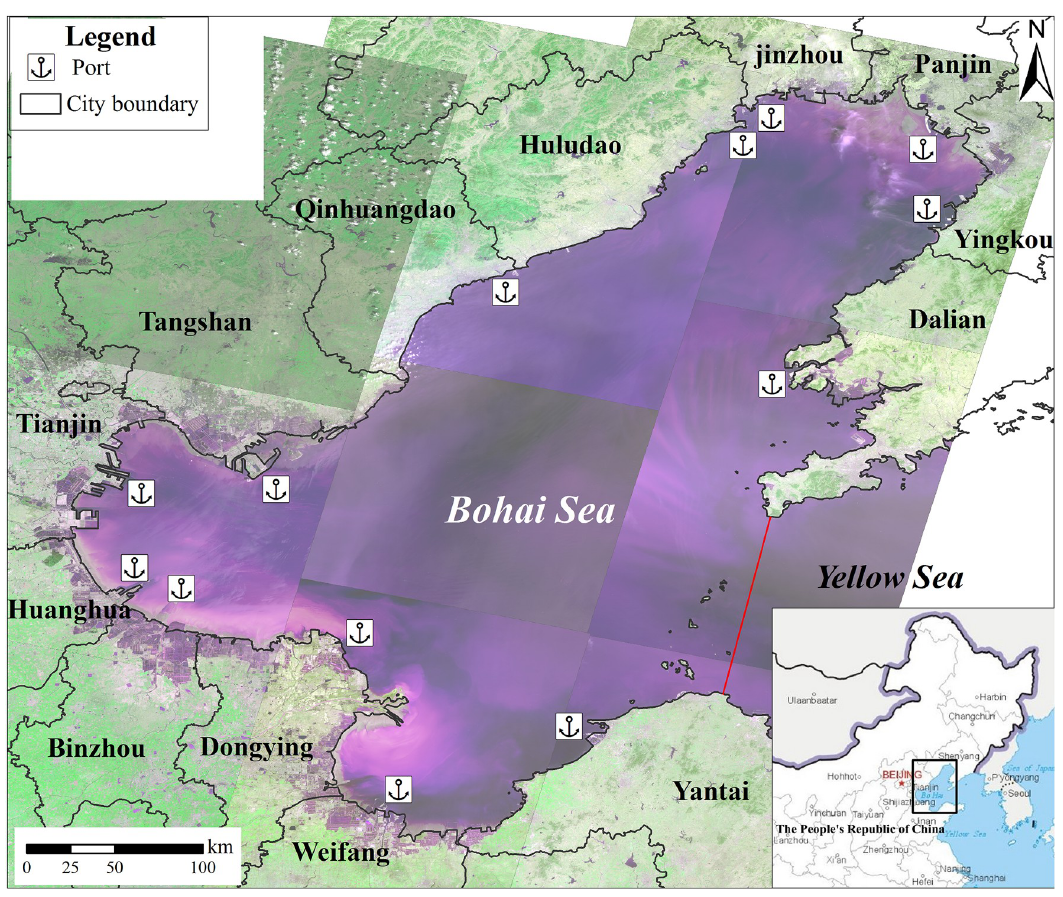
Fig 1. Location map of the study area. It includes the Liaodong Bay, Bohai Bay and Laizhou Bay. The region is located in Liaoning, Tianjin, and Hebei and Shandong. The coastal area of the Bohai Sea has many ports and has been experiencing rapid industrialization and